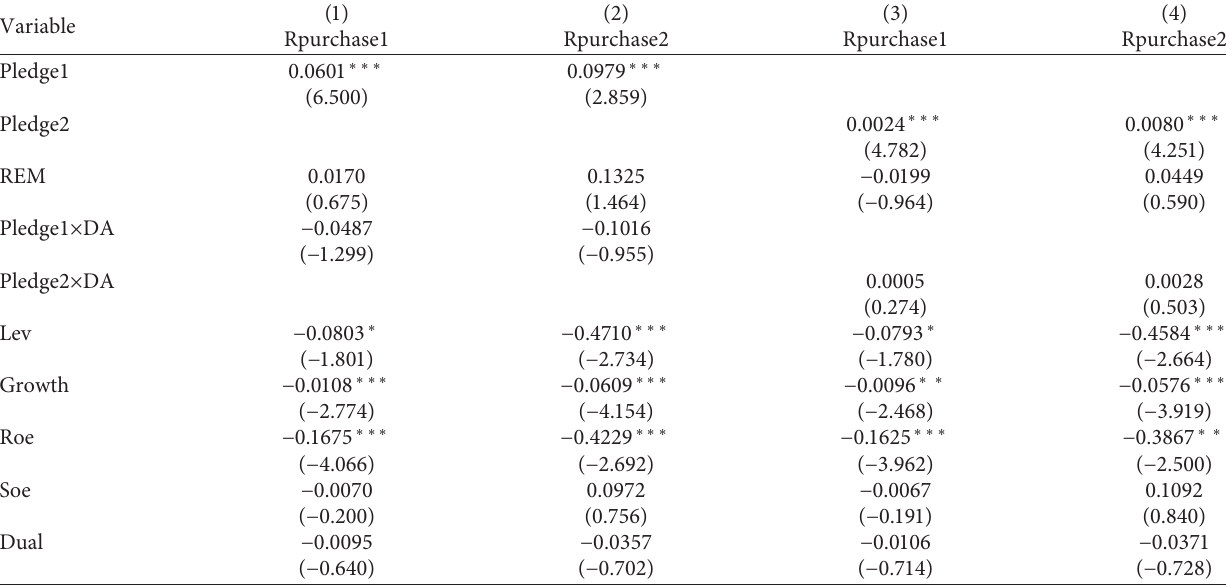
Table 11: Estimated results of controlling shareholders’ equity pledge, earnings management, and listed companies’ stock